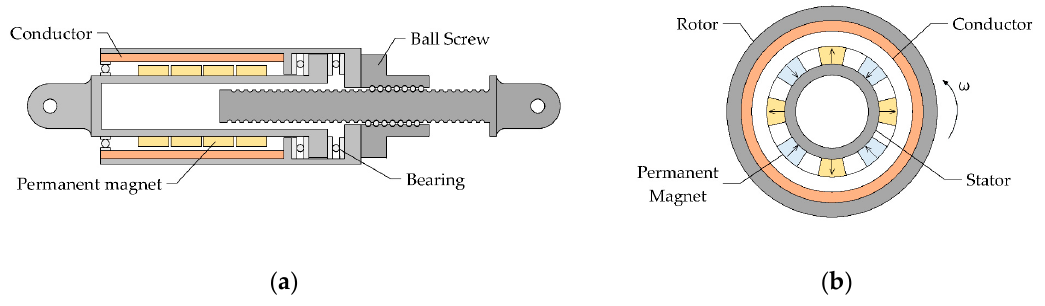
Figure 1. Cross sections of the rotary axial eddy current damper (ECD): ( a ) Longitudinal view; ( b ) transverse view.